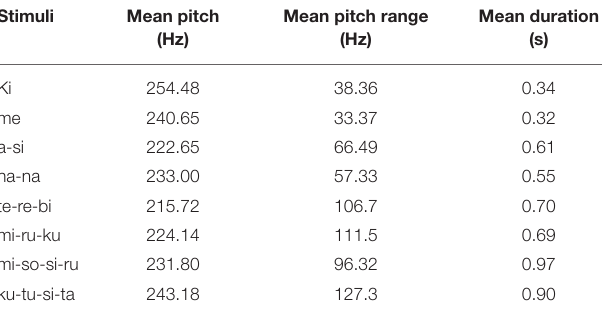
TABLE 1 | Average acoustic measurements for test stimuli.